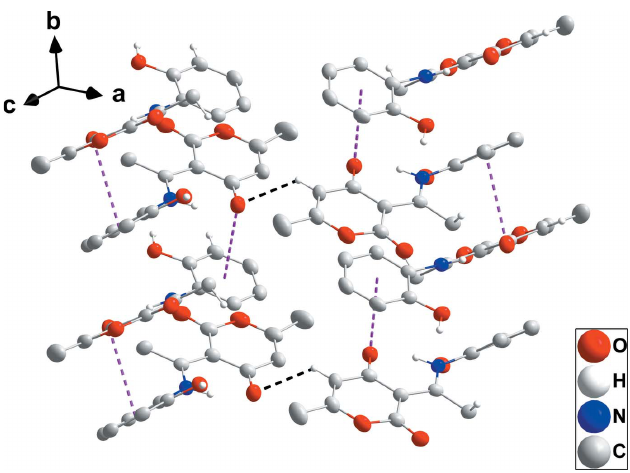
Figure 3 Detail of the C O (cid:2)(cid:2)(cid:2) (cid:2) (ring) stacking interactions (pink dashed lines) and the connection of stacks by C—H (cid:2)(cid:2)(cid:2) O hydrogen bonding (black dashed lines). Non-interacting H atoms are omitted for clarity.